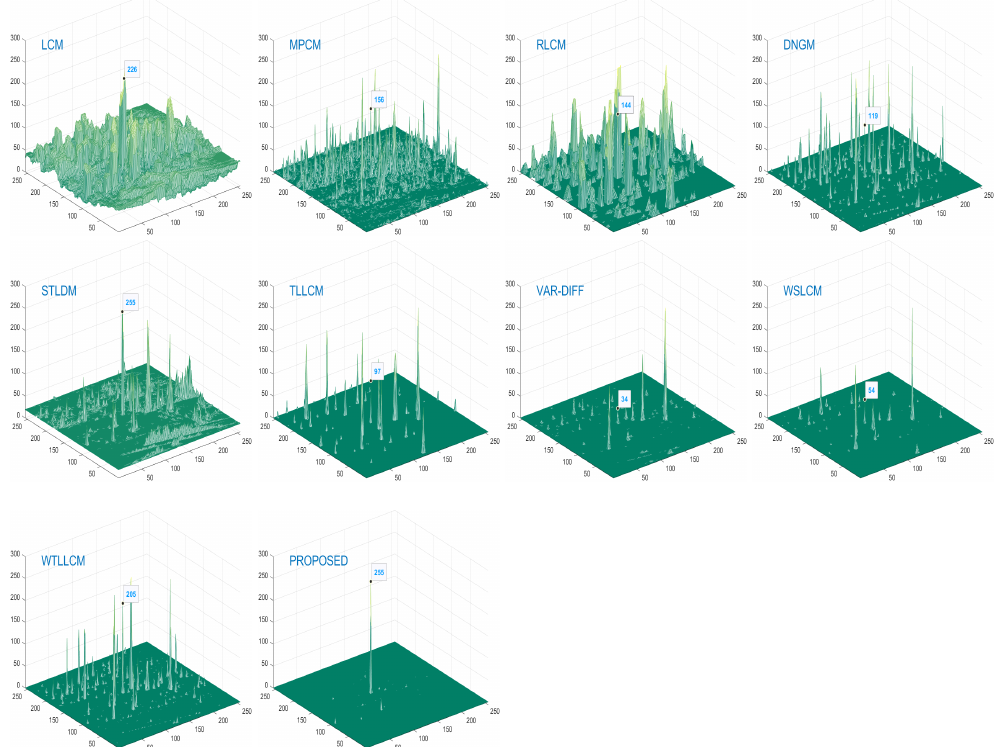
Figure A6. Three-dimensional displays of detection results on one frame in data6. Different subgraphs are the results of different